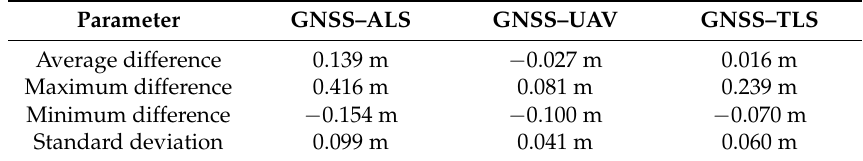
Table 7. Accuracy evaluation parameters of acquired materials for the second calculation scenario.